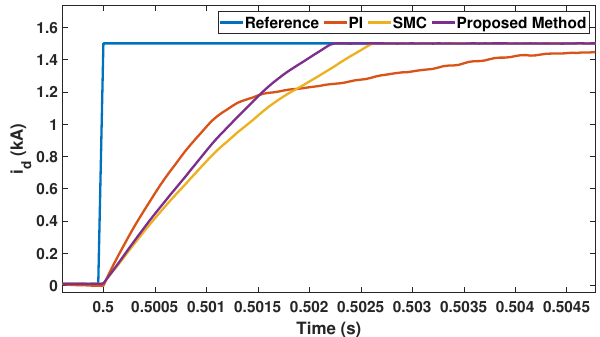
Figure 9. Zoom-in of Figure